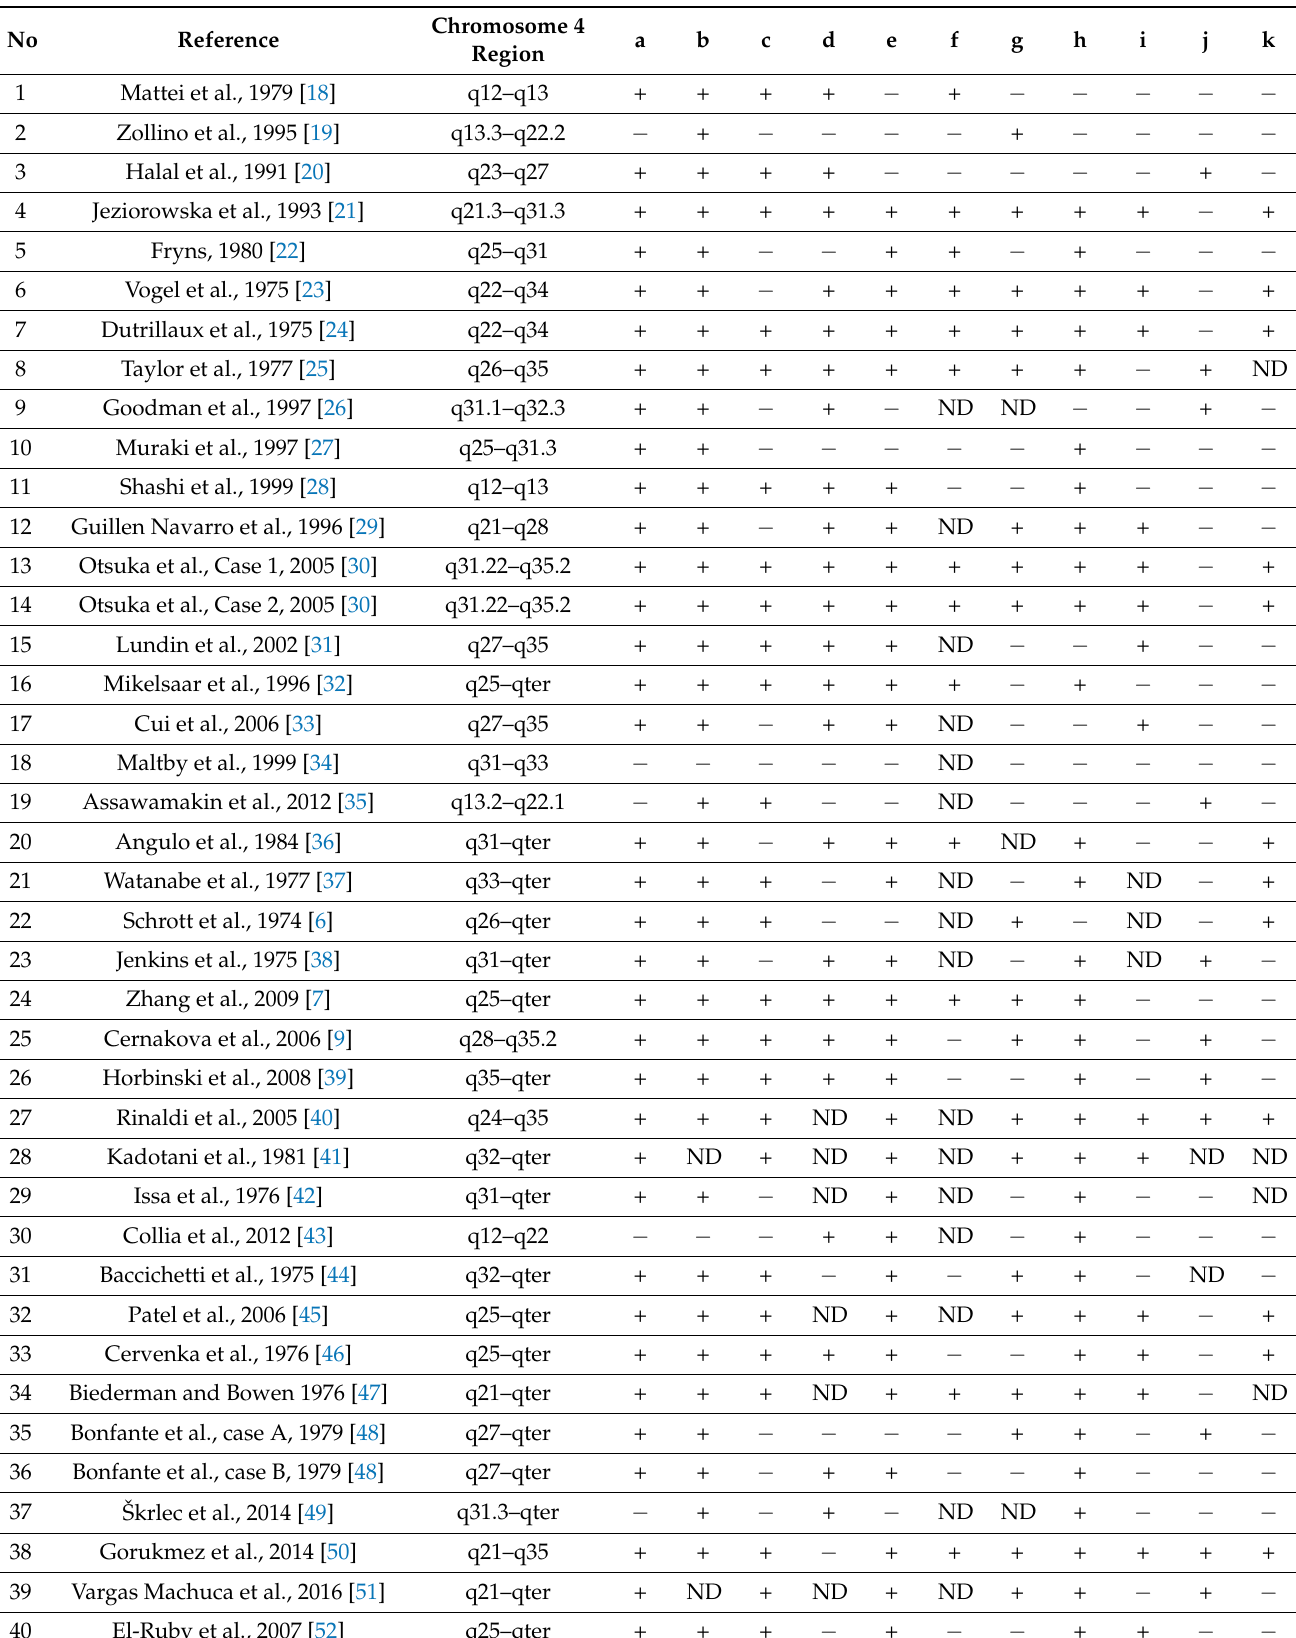
Table 2. Phenotype changes in different types of 4q partial